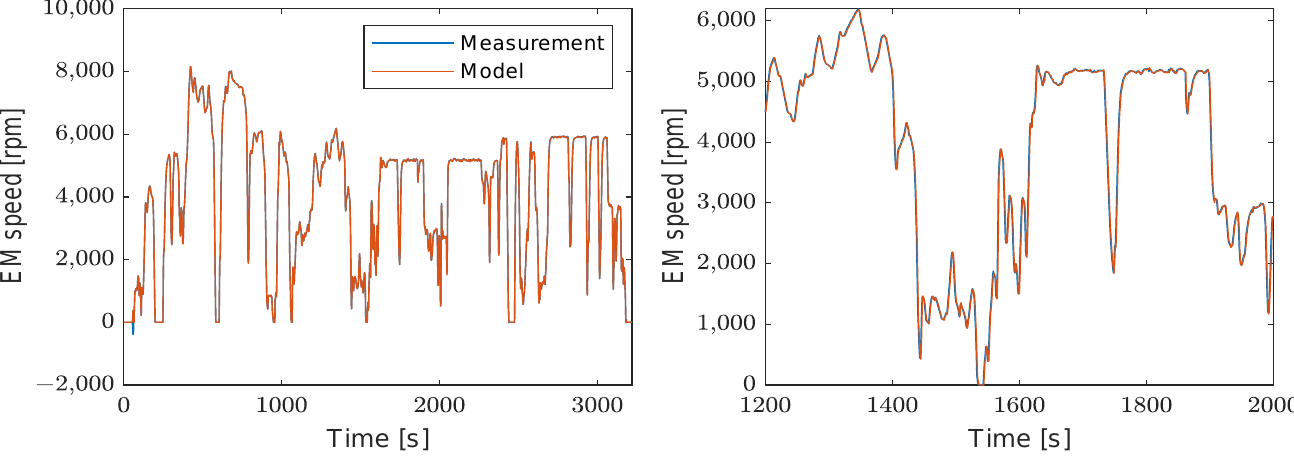
Figure A2. Validation of the EM speed for the ICDC.